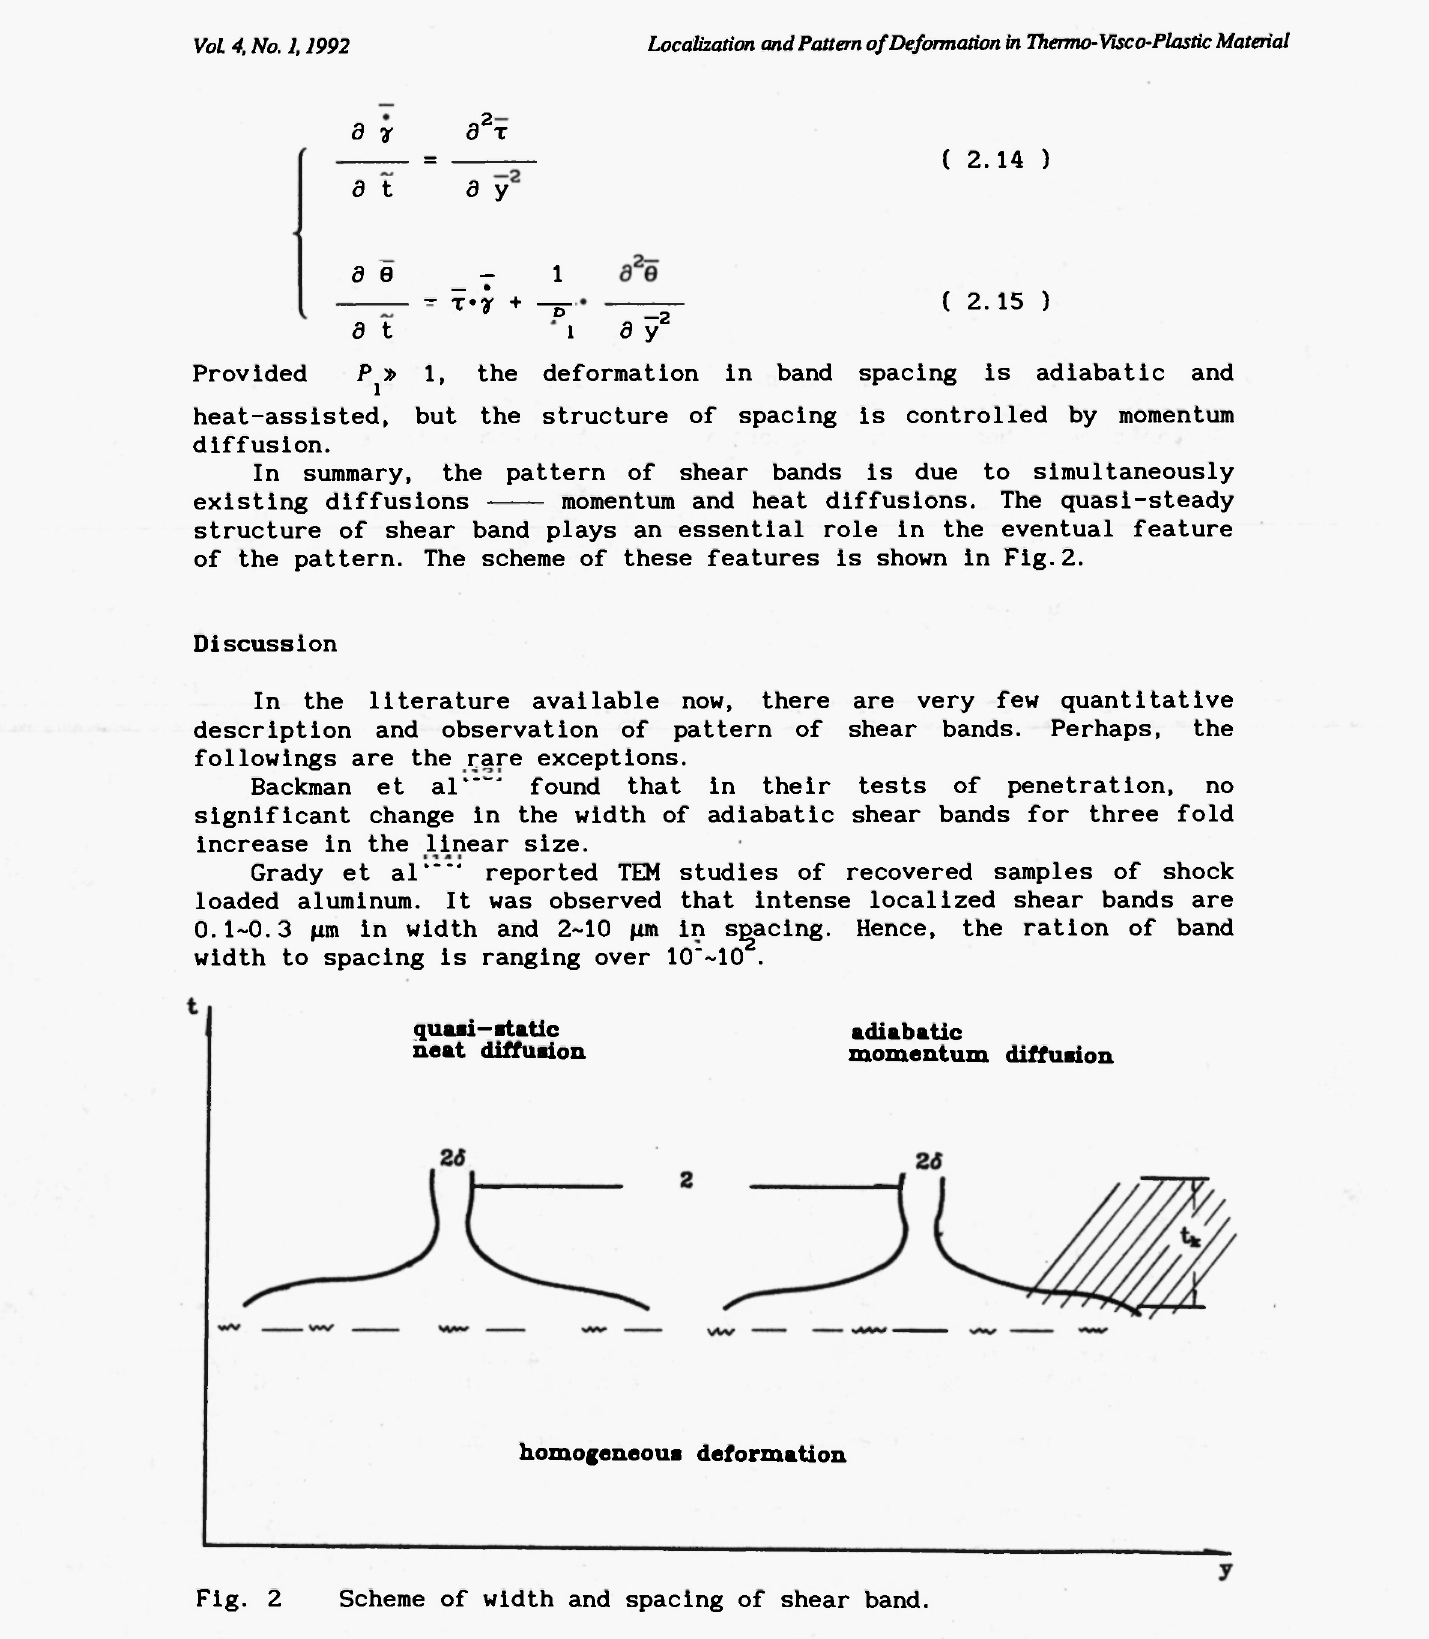
Fig. 2 Scheme of width and spacing of shear